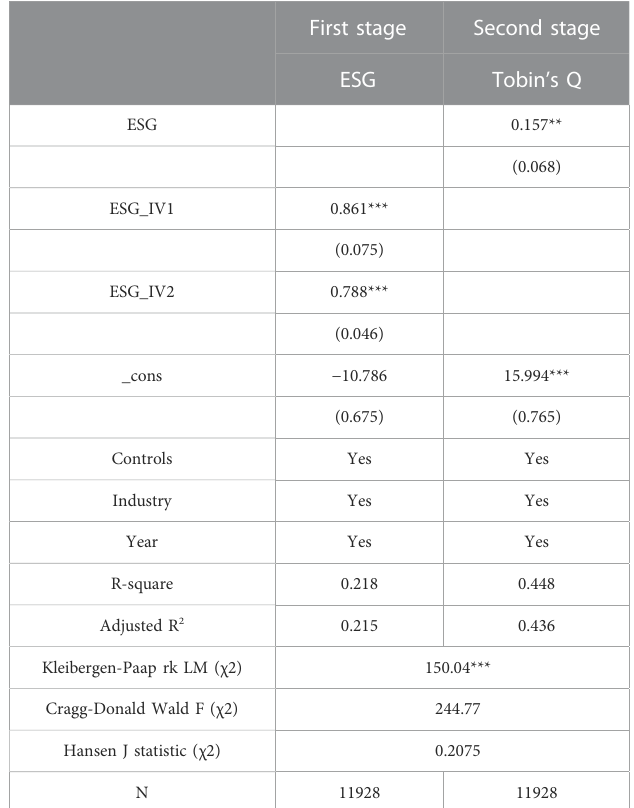
TABLE 11 Test results of IV.